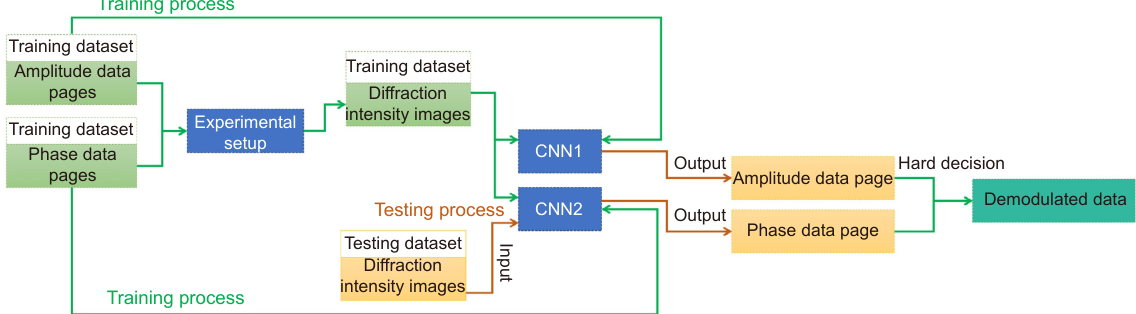
Fig. 8 | Entire process flow. The green and brown lines represent the training and testing processes,